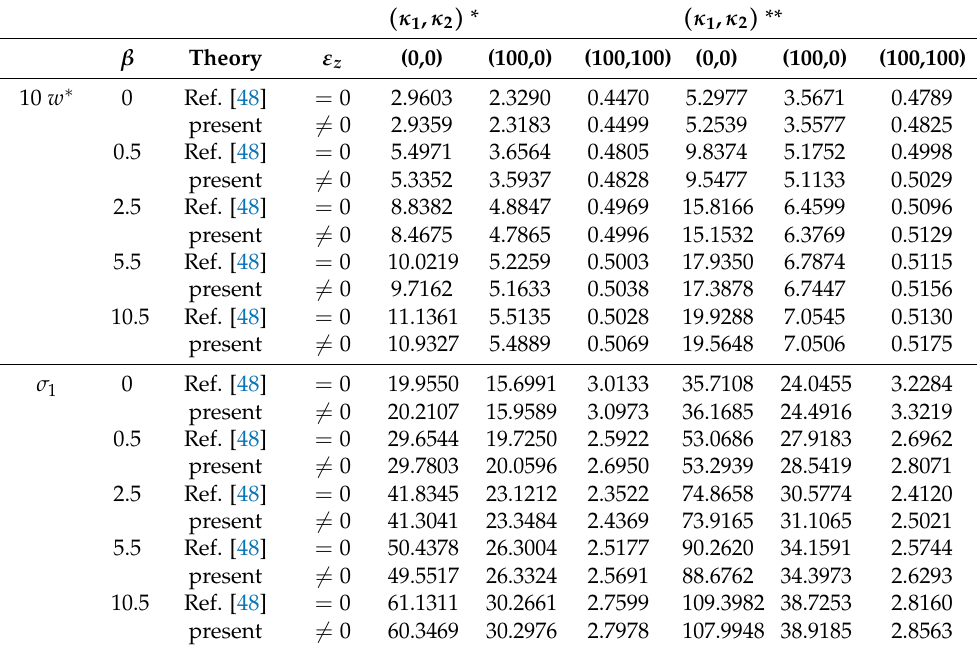
Table 5. Effects of the nonlocal coefficient, FG parameter and foundation parameters on the deflection 10 w ∗ of and in-plane normal stress σ 1 in the FG square nanoplate ( a / h = 10).